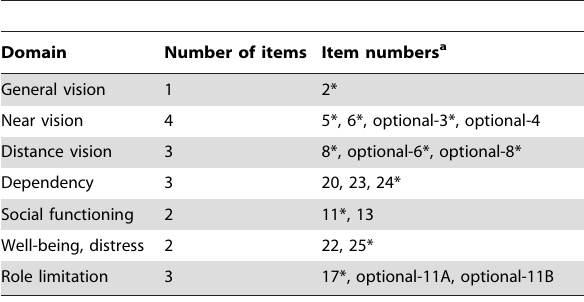
Table 2. Candidate items, and the 11 items chosen (*) for the short version of the VFQ (the VFQ-J11).